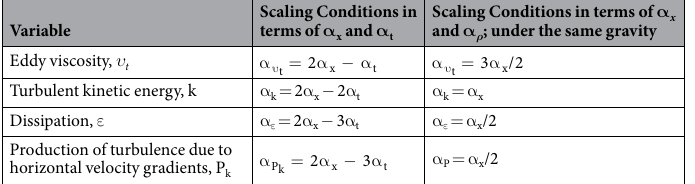
Table 2. The scaling conditions obtained by the one-parameter Lie group of point scaling transformations for the variables of the three-dimensional k - ε turbulence model.